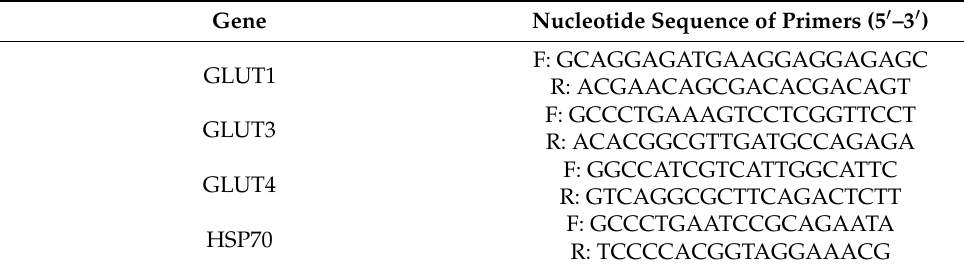
Table 5. Primers used for real-time PCR